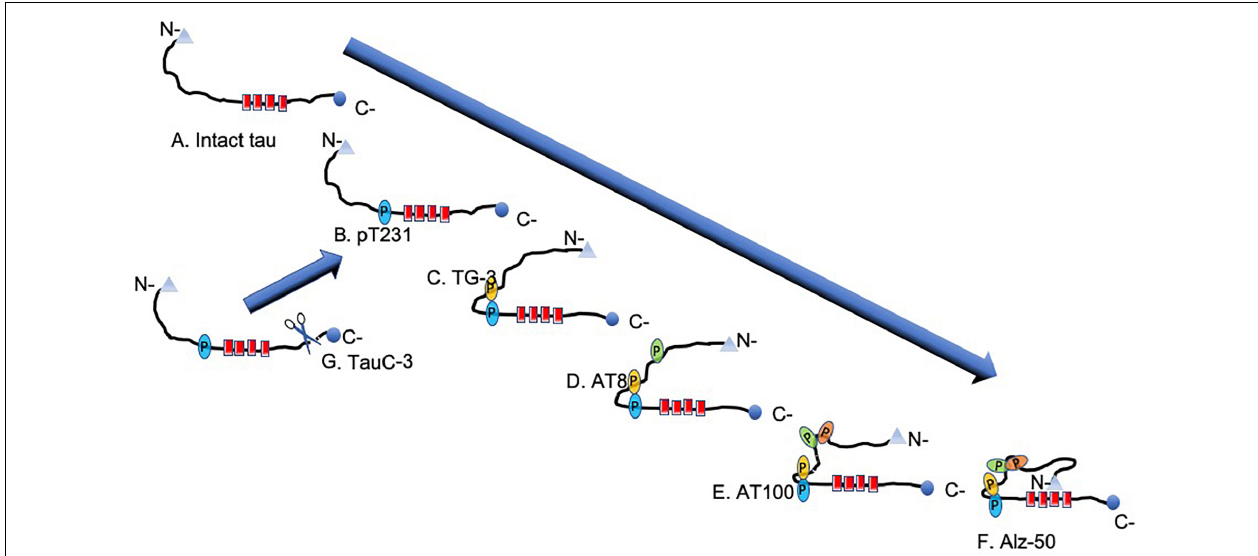
FIGURE 6 | Scheme of the stages of molecular tau processing. (A) Intact tau molecule shown. (B) On intact tau protein occurs the first phosphorylation in Thr231. This phosphorylation is decisive for the first conformational change evidenced by the TG-3 antibody (C) . (D) The amino acids 202 and 205 (AT8) are phosphorylated, which favors the phosphorylation in amino acids 212 and 214 (AT100). It generates the second pathological conformational change in tau (E) . The set of these two regional conformational changes favors the folding of the N-portion, causing the regional conformational change recognized by the Alz-50 antibody (epitopes 2–10 and 312–322) (F) . (G) In pre-neurofibrillary tangles (NFTs), there is a high activity of caspase-3, which acts once the tau protein is phosphorylated in pT231.